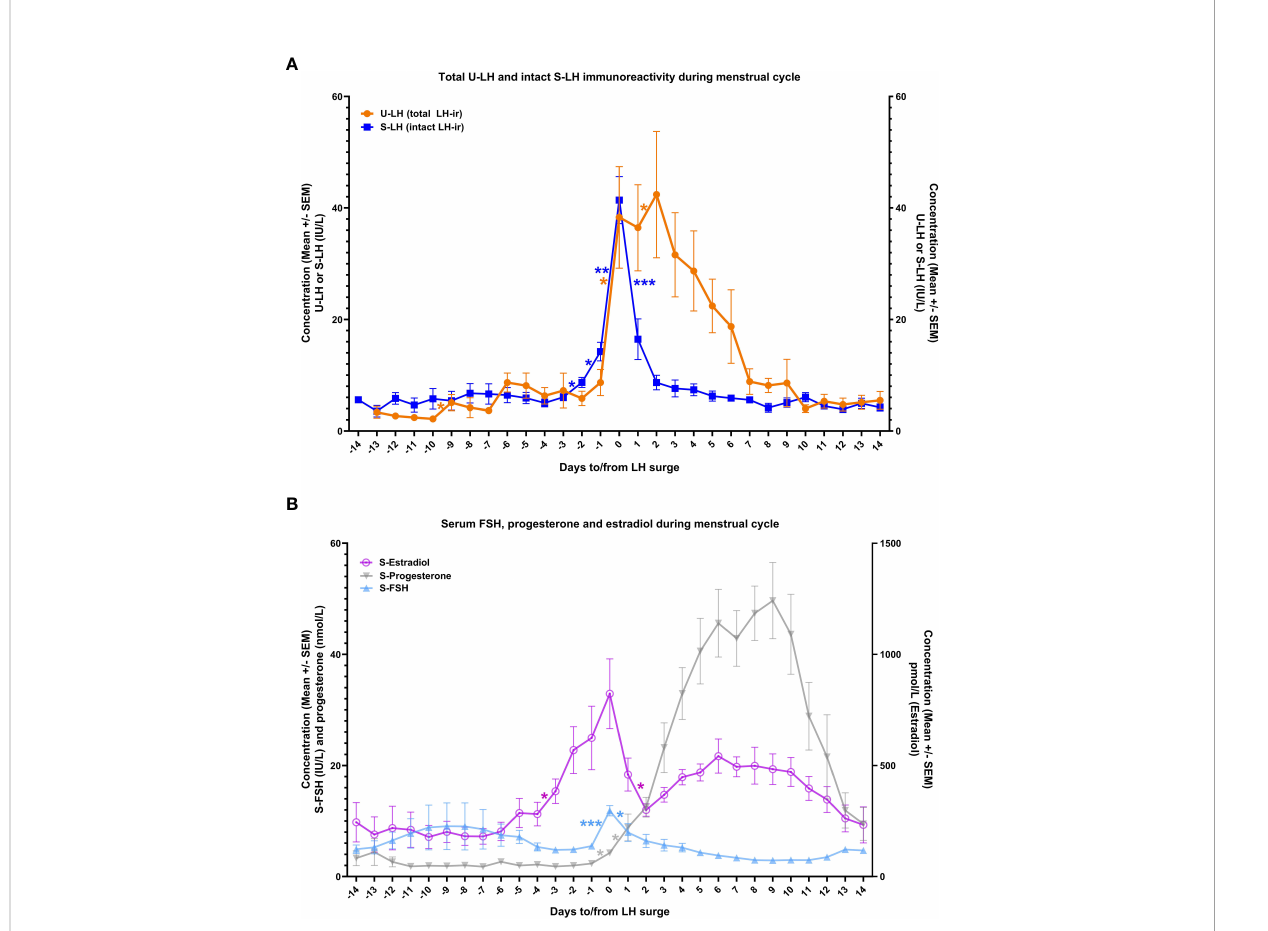
FIGURE 1 The course of total luteinizing hormone immunoreactivity (LH-ir) in urine and intact LH-ir in serum (total U-LH-ir and intact S-LH-ir, respectively) [panel A ], and follicle-stimulating hormone (FSH), progesterone, and estradiol in serum [panel B ] during the menstrual cycle. Symbols depict the mean values and bars represent the standard error of the mean. The statistically signi fi cant changes are denoted as follows: *P<.05, **P<.01,